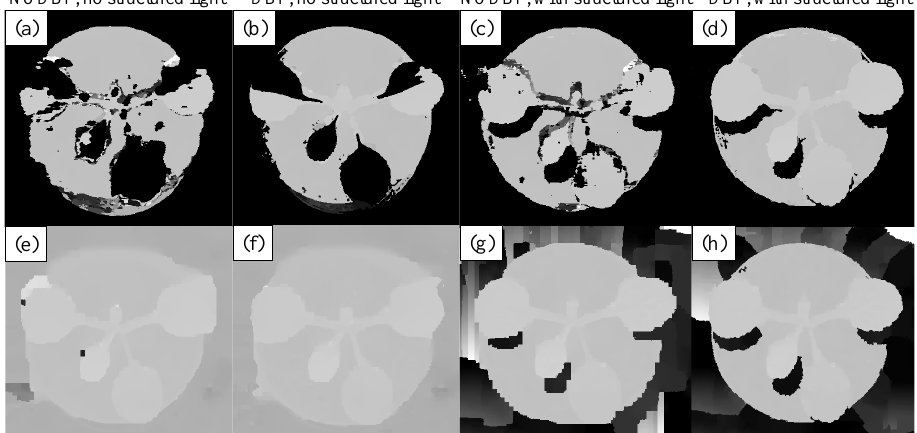
Figure 5. Results of the block matching (BM) (first row) and belief propagation (BP) (second row) algorithms with the use of disparity bilateral filtering (DBF) and structured light (SL): ( a ) BM result without SL; ( b ) BM + DBF result without SL; ( c ) BM result with SL; ( d ) BM + DBF result with SL; ( e ) BP result without structured light (SL); ( f ) BP + DBF result without SL; ( g ) BP result with SL; and ( h ) BP + DBF result with SL. The BM + DBF algorithm with SL is used in our